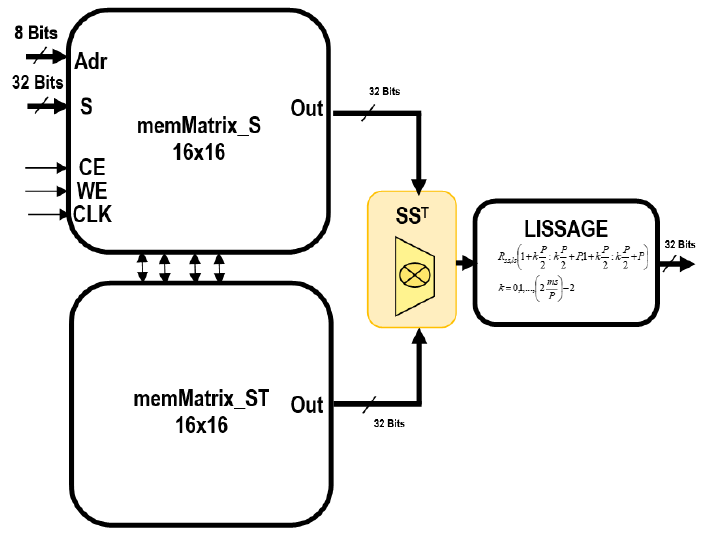
Figure 3. Hardware architecture of covariance